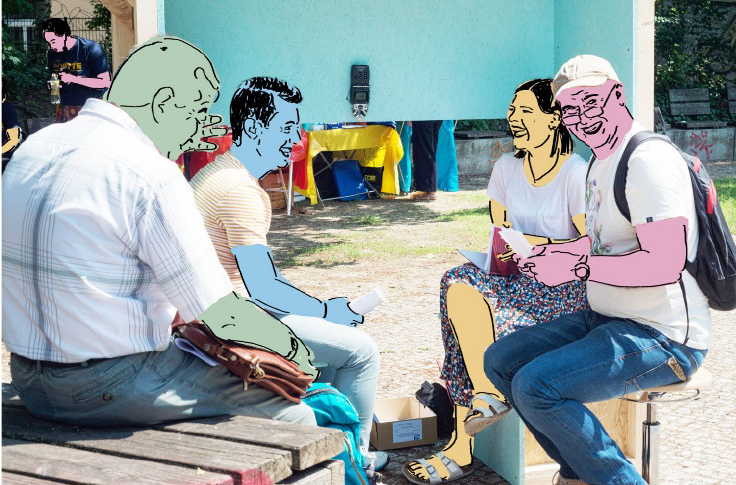
Figure 1. Story‐corner. Photograph by Michael Shenbrot and illustrations by Zeynep Keskin. Source: Courtesy of ©